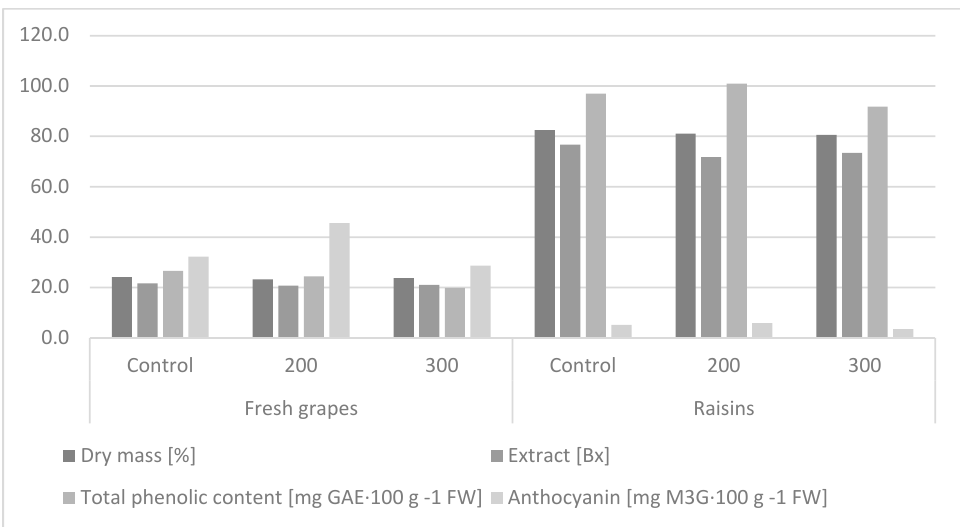
Figure 2. Effect of the hormone treatment on dry matter, extract level, and total phenolic and anthocyanin content in fruits and raisins of the ‘Einset Seedless’ cultivar.